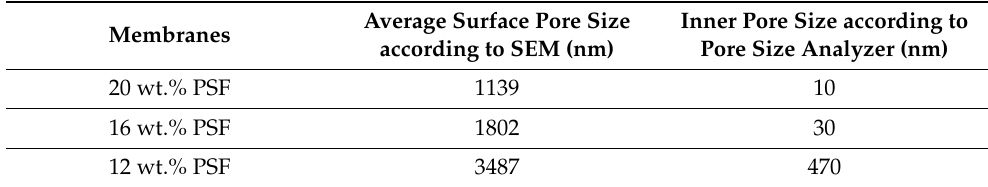
Figure 2. Pore size analysis of PSF membranes: ( a ) 12 wt.%; ( b ) 16 wt.%; ( c ) 20 wt.%. Table 1. Surface and inner pore size analysis at various weight percentages (wt.%) of polysulfone (PSF)